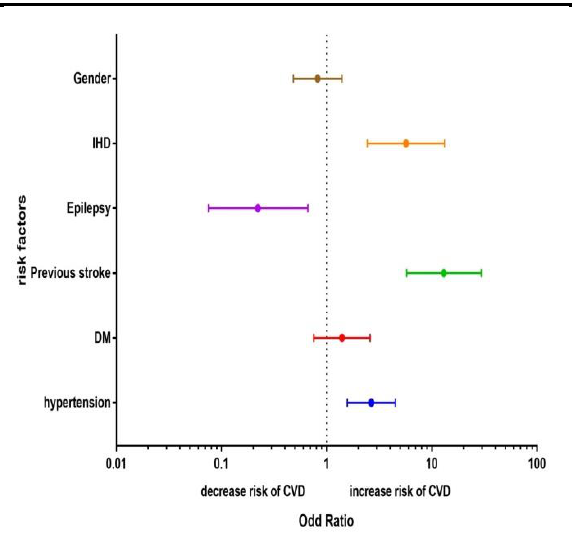
Figure 3: Forest plot of risk factors and predictors for CVD Table 5: risk of new onset stroke according to age